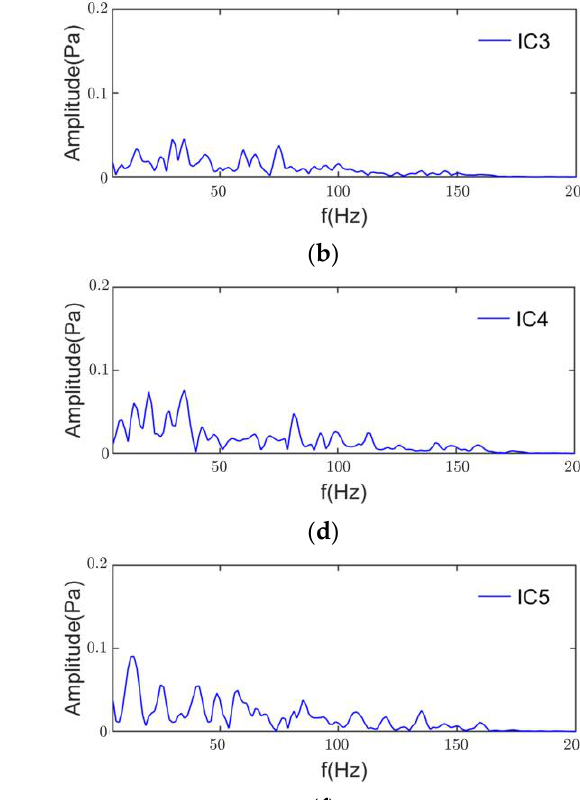
Figure 17. PSD and envelope spectrum of IC3-IC5: ( a ) PSD of IC3; ( b ) envelope spectrum of IC3; ( c ) PSD of IC4; ( d ) envelope spectrum of IC4; ( e ) PSD of IC5; ( f ) envelope spectrum of IC5 .